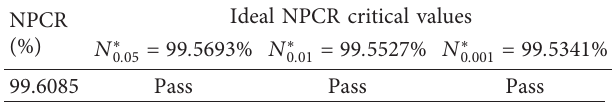
Table 11: UACI analysis of test image. UACI